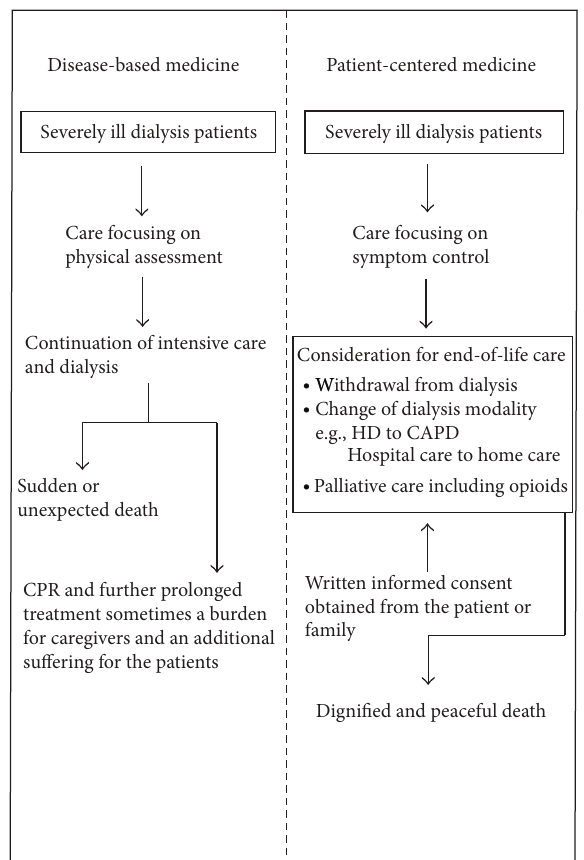
Figure 1: Concept of seriously ill dialysis patients showing a comparison between disease-based and patient-centered medicine. To ensure a peaceful death for these patients it is necessary to have cooperation between medical staff members such as dialysis nurses, social workers, and home doctors and nurses. Sufficient time is required to arrange the care for each patient. We consider that these clinical practices are consistent with patient-centered